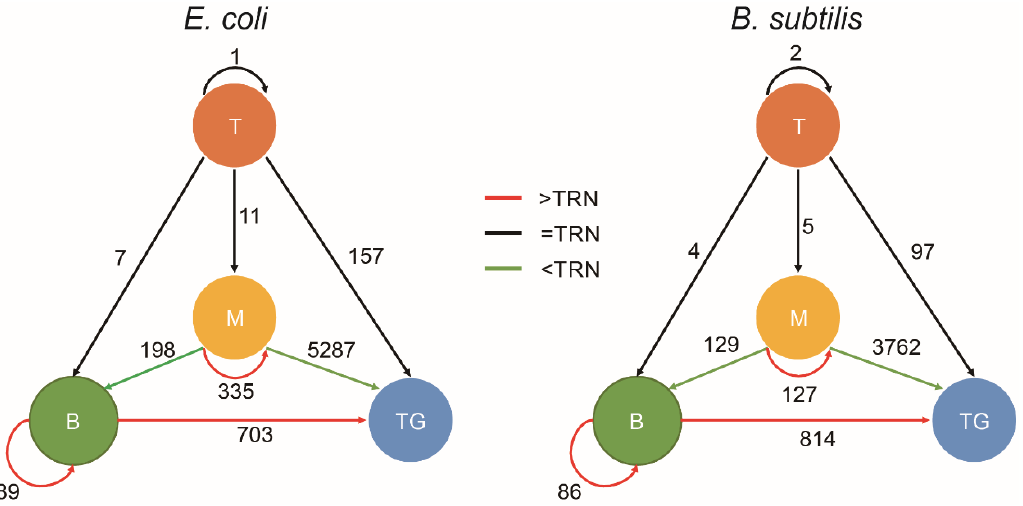
Figure 2. The spatial organization of the TRN hierarchy. The four spheres T, M, B, and TG represent top, middle, bottom and target layers in the hierarchy, respectively. The numbers on the edges represent the numbers of regulatory relationships within or between layers. The color of edge represents the comparison result of the chromatin interaction frequency of the edge with the TRN. Significance level: p < 0.05.